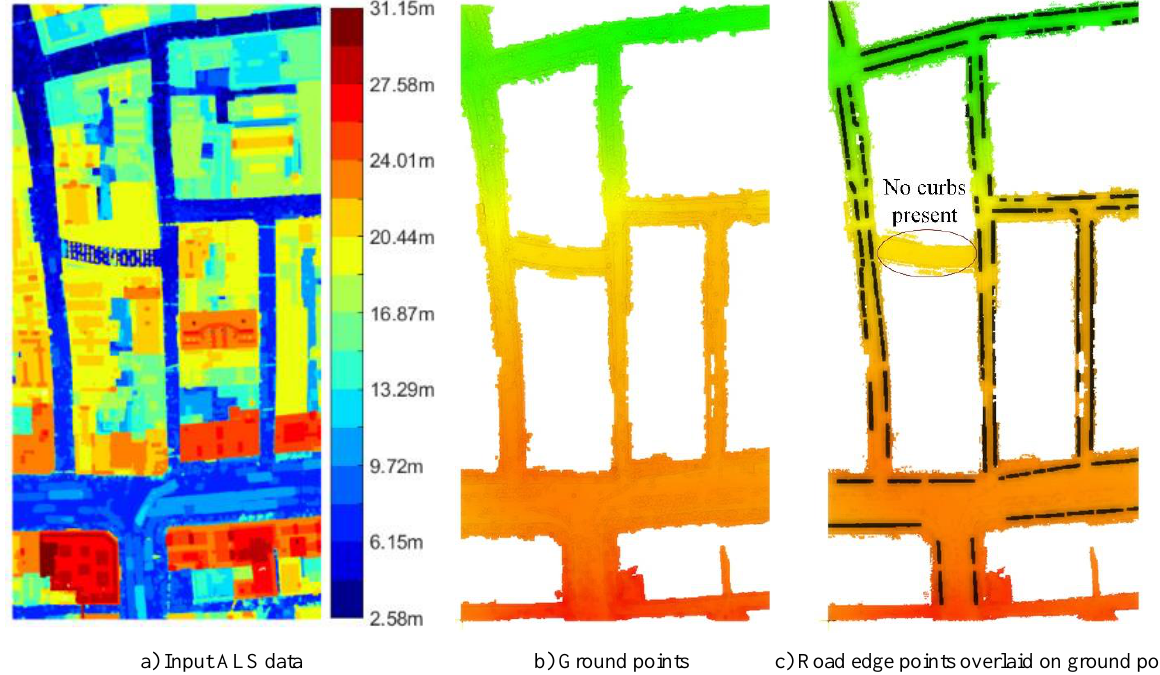
Figure 5. Results of road edge point extraction from selected ALS data in Dublin